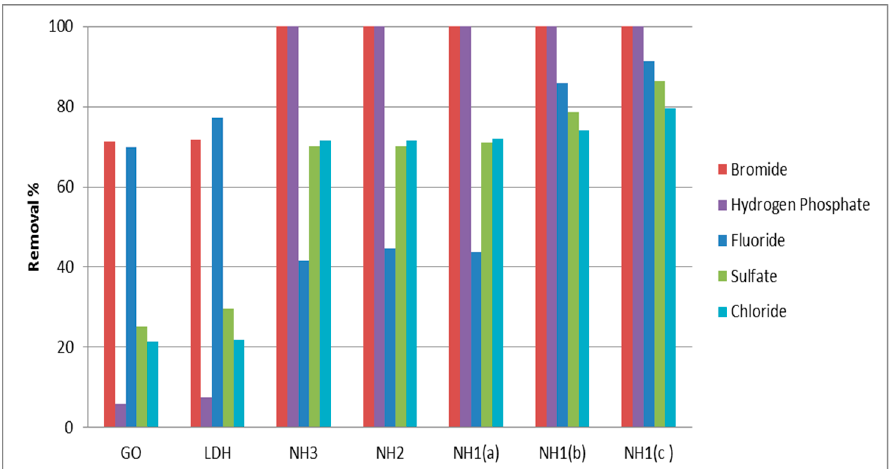
Figure 9. Removal efficiency of selected anions toward the different structures prepared: ( a ) W/V = 10 g/L, ( b ) W/V = 20 g/L, ( c ) W/V = 30 g/L.